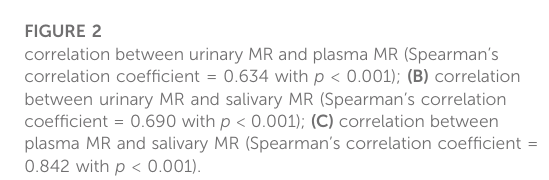
FIGURE 2 correlation between urinary MR and plasma MR (Spearman ’ s correlation coef fi cient = 0.634 with p < 0.001); (B) correlation between urinary MR and salivary MR (Spearman ’ s correlation coef fi cient = 0.690 with p < 0.001); (C) correlation between plasma MR and salivary MR (Spearman ’ s correlation coef fi cient = 0.842 with p <